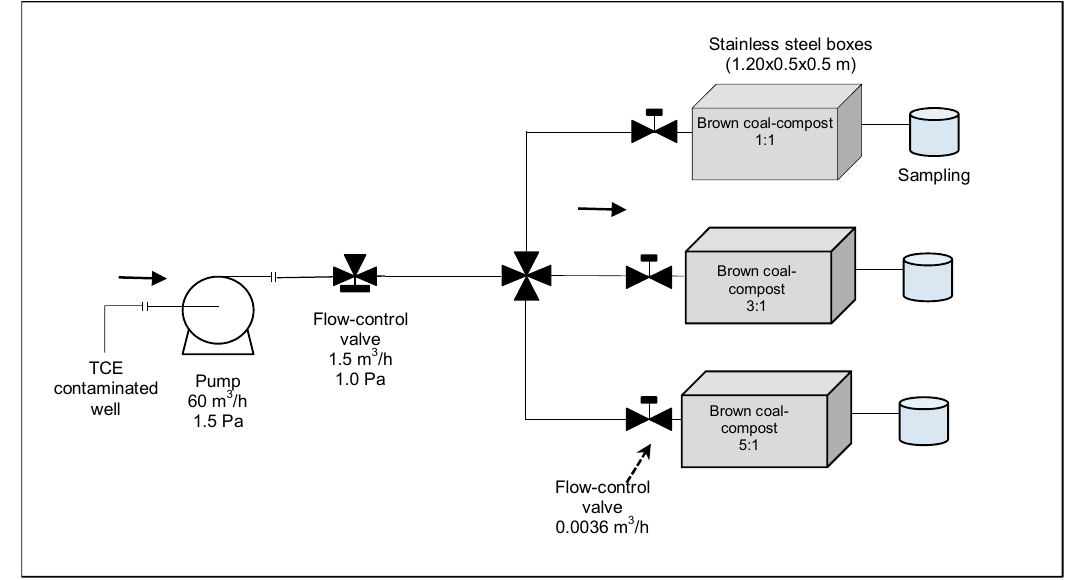
Figure 2. Schematic representation of the pilot brown coal-compost permeable reactive barrier (PRB) installation at the site.